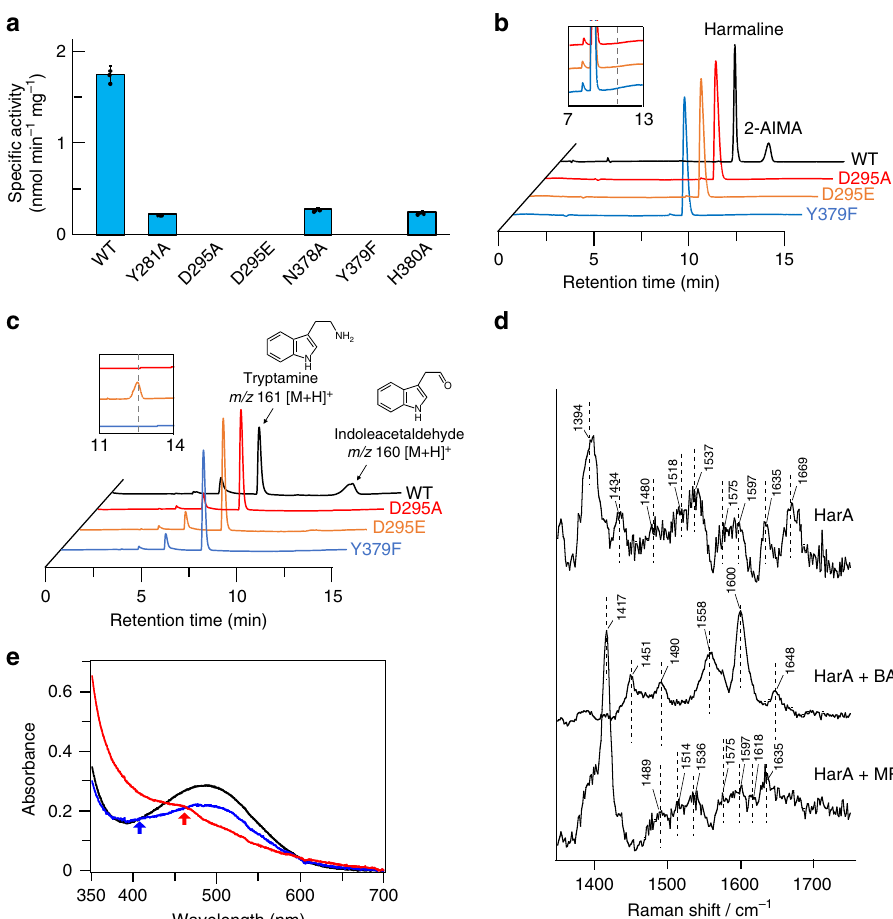
Fig. 5 Identi fi cation of catalytic residues and reaction intermediates of HarA-catalyzed reaction. To obtain insight into the reaction mechanism of HatA- catalyzed cyclic imine cleavage reaction, various biochemical analyses were performed. a Speci fi c activities of HarA mutants. All data points represent the mean values ± S.D. for three experiments. Source data are provided as a Source Data fi le. The reaction mixtures containing each of wild-type HarA, and the D295A, D295E and Y379F mutants were incubated with each of b harmaline and c tryptamine, and analyzed by LC/MS. Insets: magni fi ed chromatograms (×10) of the three mutant enzymes. Dashed lines indicate the retention time in which each of the reaction products is detected. d Raman spectra of HarA without a substrate and with each of benzylamine (BA) and methylenepiperidine (MP) are shown. All spectra were obtained by subtracting the spectra of the Y379F mutant from those of native HarA. e UV-vis spectra of HarA were obtained with a spectrophotometer with an amine or imine substrate in an anaerobic environment. HarA was added to the reaction mixture containing 13 equivalents of benzylamine (blue), 5 equivalents of 2-methylenepiperidine (red), or 1% dimethylsulfoxide (black). Arrows indicate the peaks that appeared upon the addition of each